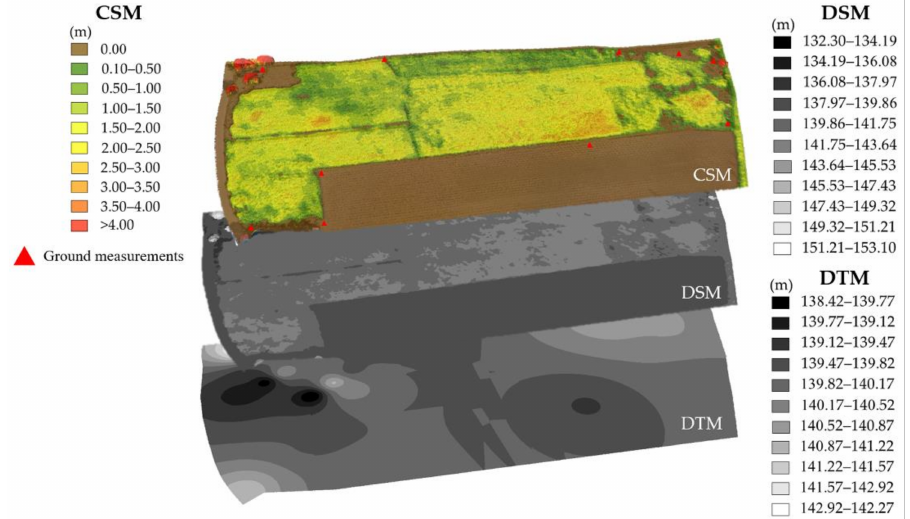
Figure 22. The 3-dimensional model of sugarcane height was generated using UAV DJI phantom 3 professional observed on 16 December 2020 at field scale in Northeast of Thailand; crop surface model (CSM) (top level) subtracted by the digital surface model (DSM) (middle level) and digital terrain model (DTM) (bottom